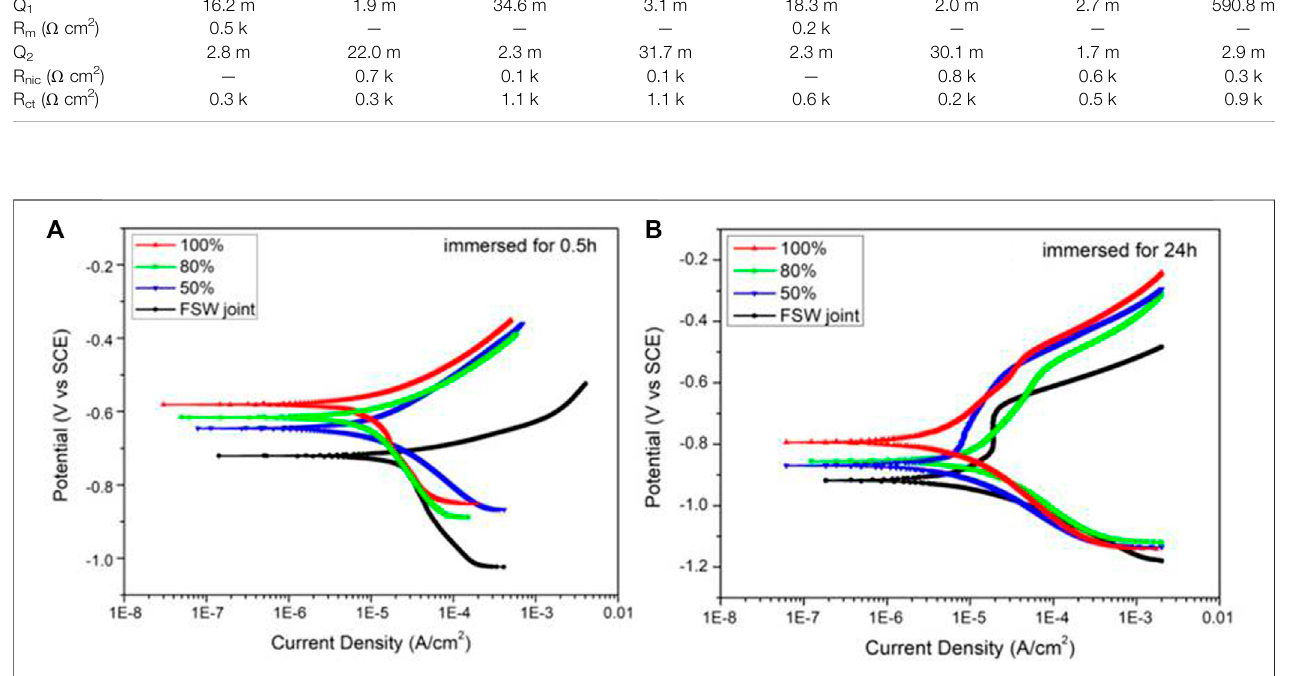
Frontiers in Materials |